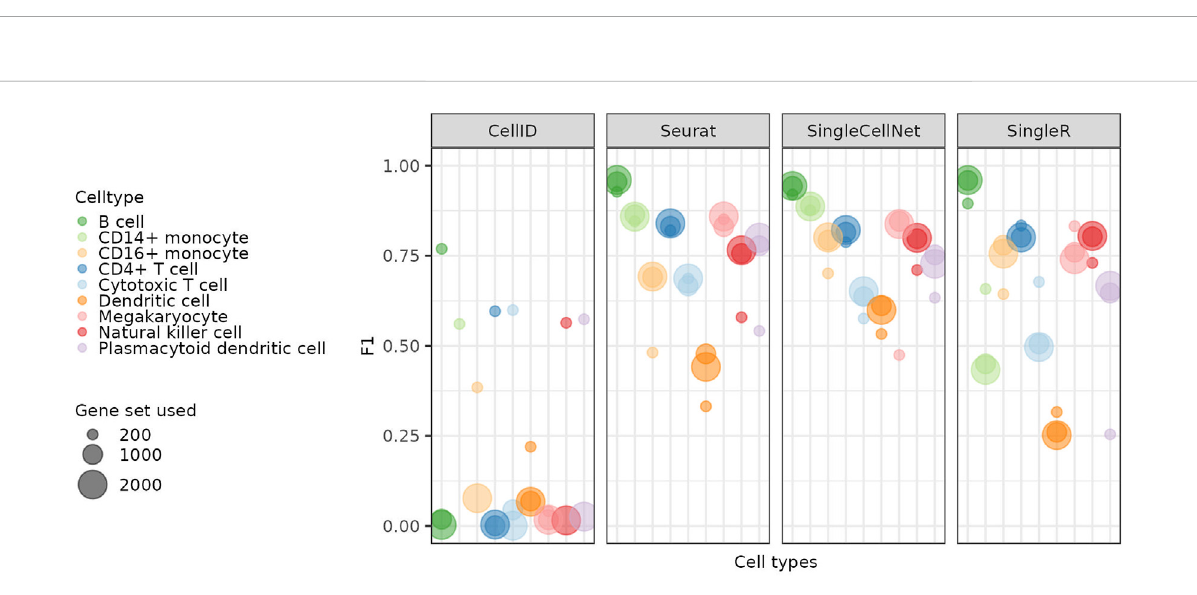
FIGURE 6 Comparing predictions based on different gene sets Cell type speci fi c F1 scores achieved with the different gene sets for each of the methods. The 1,000 and 2000 genes sets yield better predictions than the 200 genes set for most methods and cell